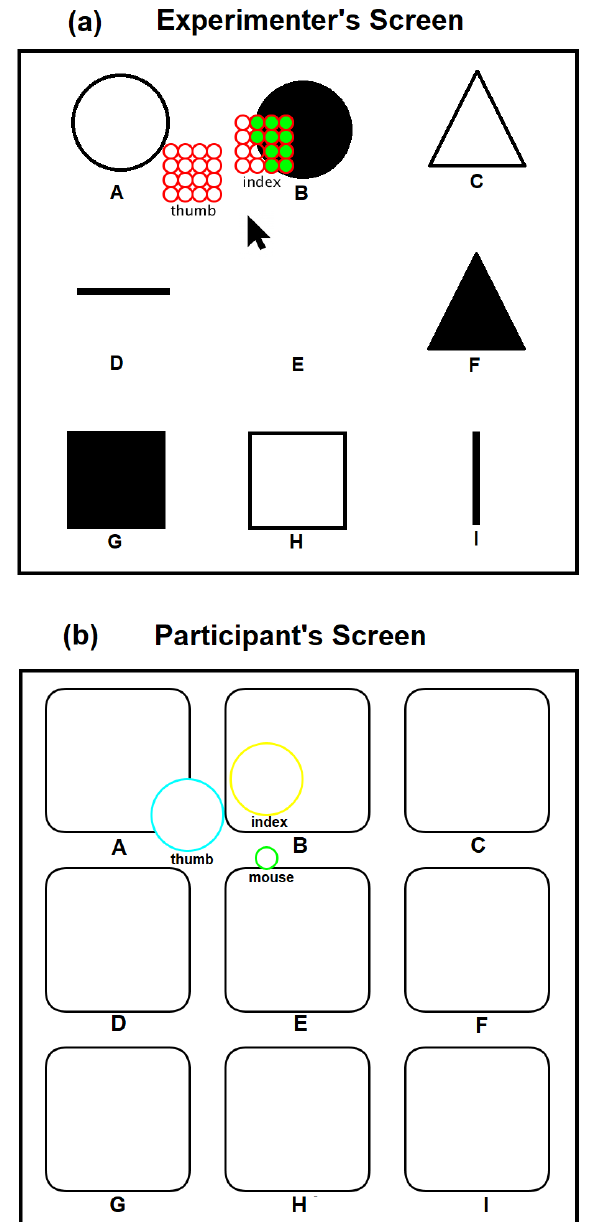
Figure 20. Patterns for 2D scanning test. ( a ) Experimenter’s screen, ( b ) participant’s screen. Partici- pants were able to see empty boxes to explore and identify the objects A to